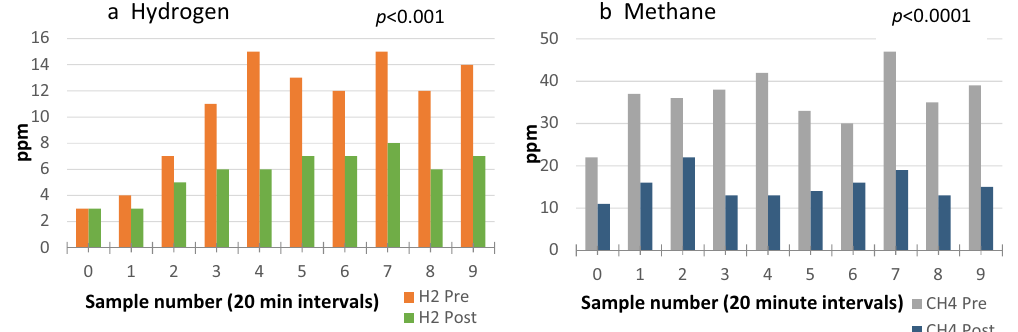
Figure 2. Changes in breath hydrogen ( a ) and methane ( b ) in one subject following chlorhexidine mouthwash at each time-point for the duration of breath testing. H 2 , hydrogen; CH 4 , methane; Pre, before mouthwash; Post, after mouthwash.